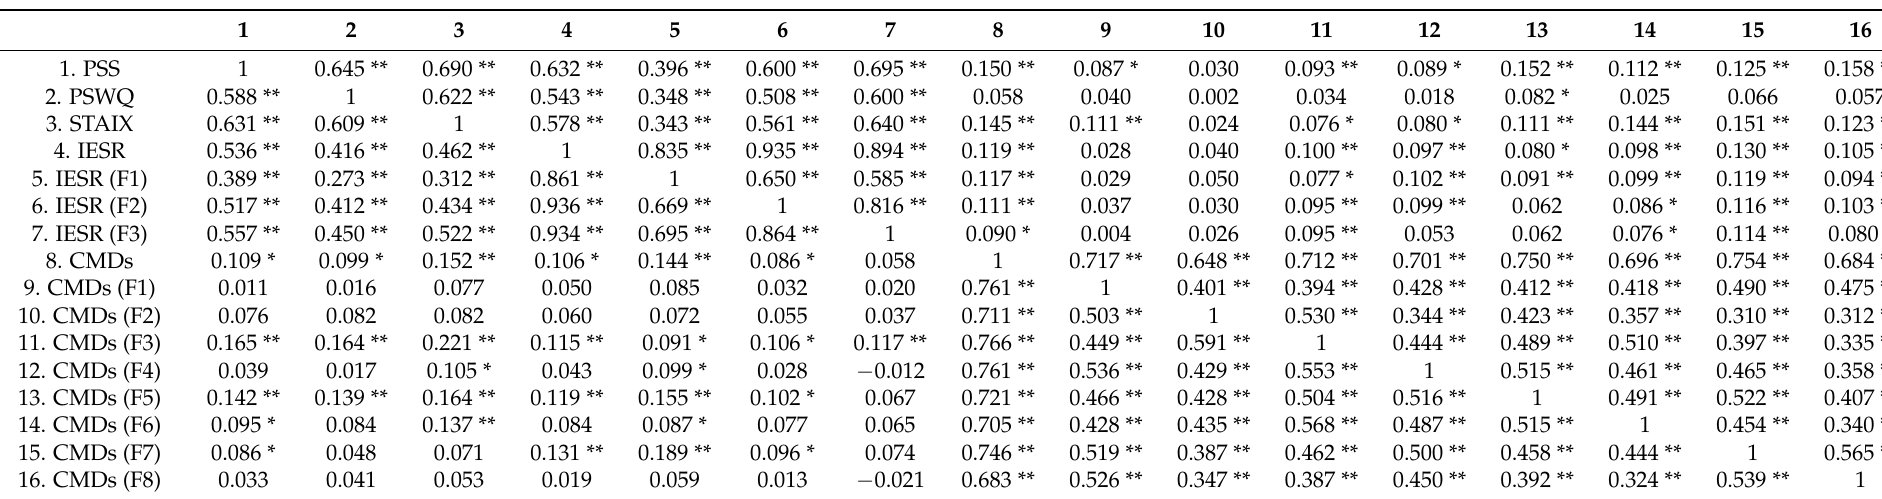
Table 1. Correlation among the variables in March 2020 (T1, over the diagonal) and August 2020 (T2, below the